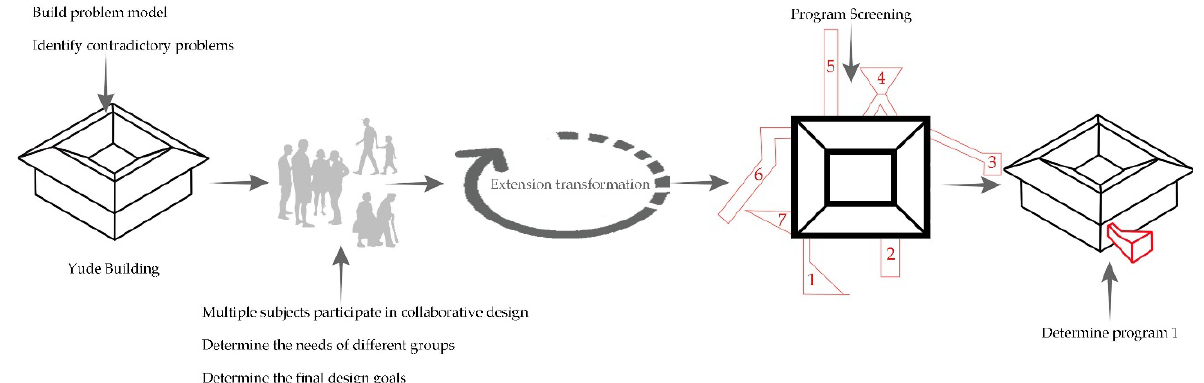
Figure 13. Demonstration process of the space renovation in the Yude Building.